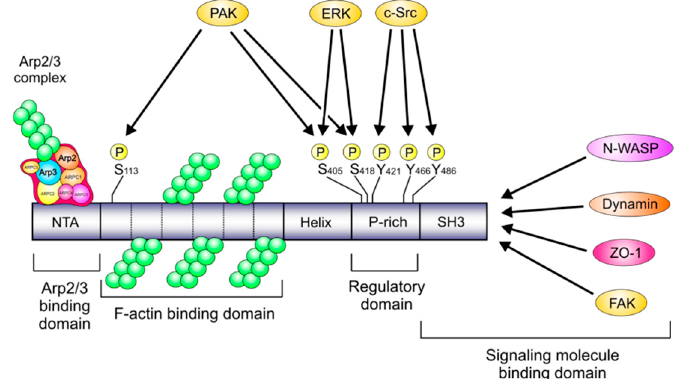
Figure 1. Simplified model of the cortactin protein due to cell infection with Helicobacter pylori : domain structure, phosphorylation sites, and interaction partners. The NTA and F-actin binding domains of cortactin provide stabilization of the Arp2 / 3-mediated F-actin branches. The prolin-rich domain harbors phospho-sites for the tyrosine and serine / threonine kinases ERK1 / 2, PAK, and c-Src; however, the target S-113 for PAK kinase is located in the “cortactin repeat” domain. The carboxy-terminal SH3 domain of cortactin has been shown to interact with more than 10 proteins [23,24,26,27,31–33,45–50], four of which, namely N-WASP, dynamin, ZO-1 and FAK have been shown to be a ff ected during H. pylori infection [24,51–53]. However, the interaction of ZO-1 and dynamin with cortactin during H. pylori infection remains not clear.